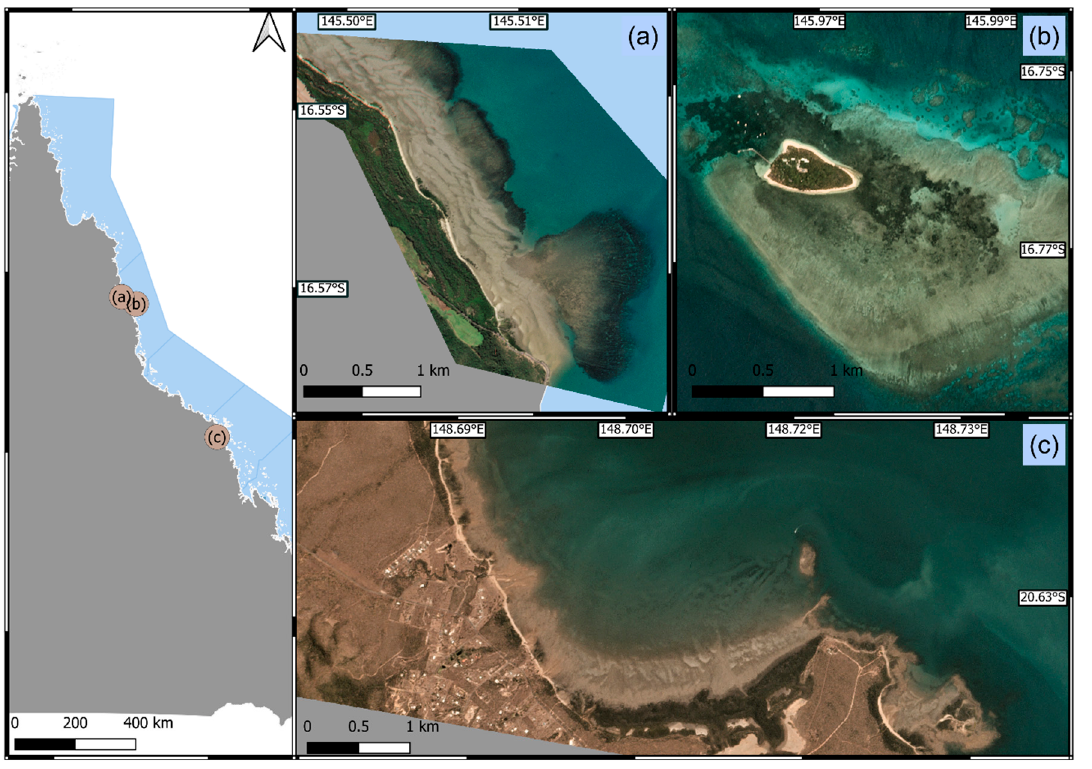
Figure 2. Location of each case study: ( a ) coastal clear water (Yule Point); ( b ) reef clear water (Green Island); and ( c ) coastal turbid water (Midge Point).